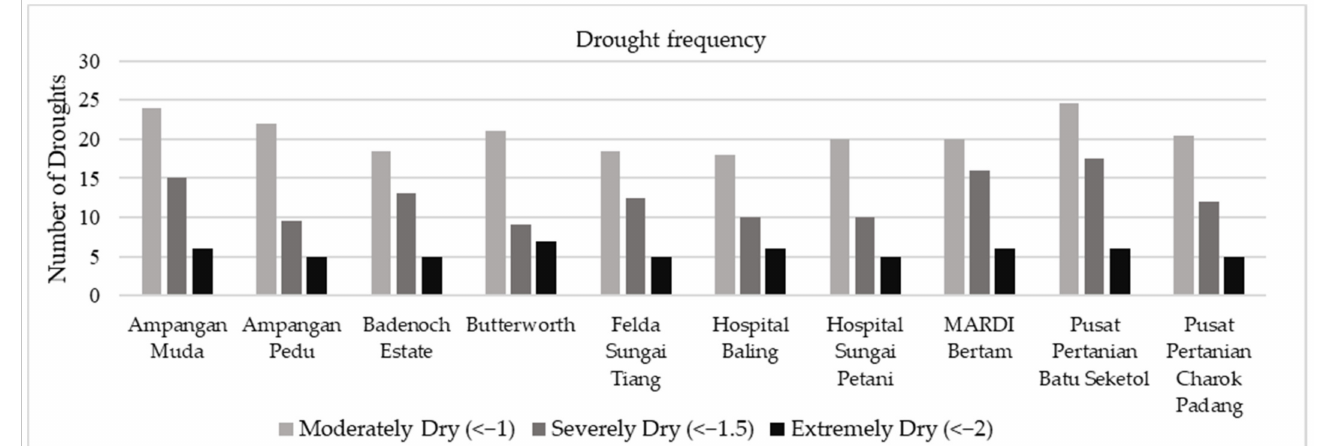
Figure 4. Drought occurrence frequency based on the intensity of drought.